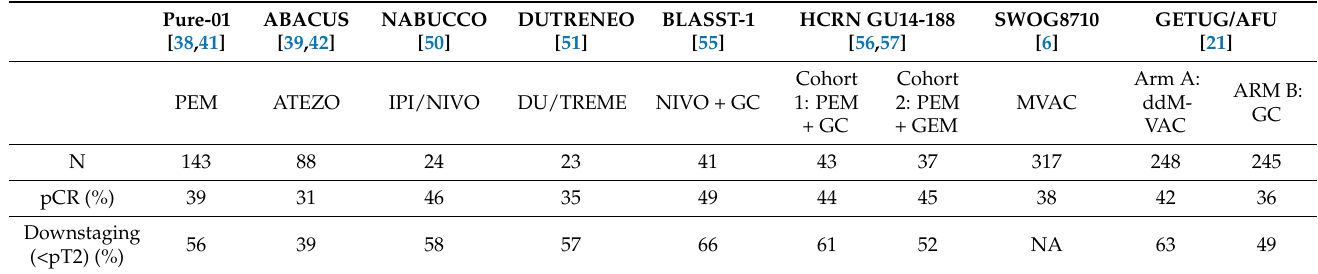
Table 7. Summary of pathologic response in major neoadjuvant